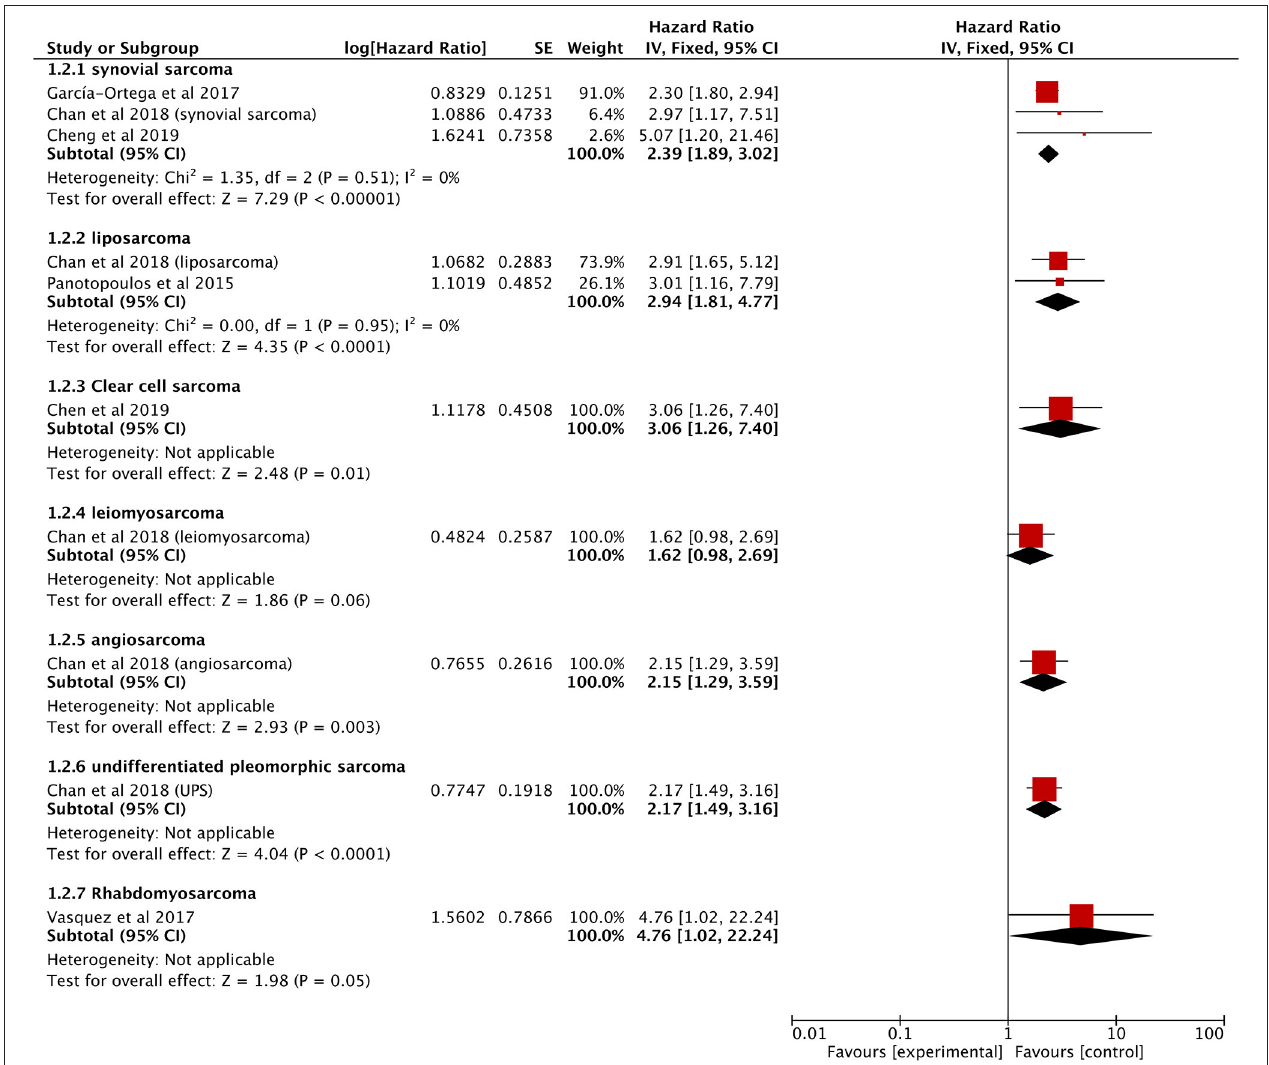
FIGURE 3 | Forest plots of the Prognostic effect of NLR for OS in different histological subtypes.